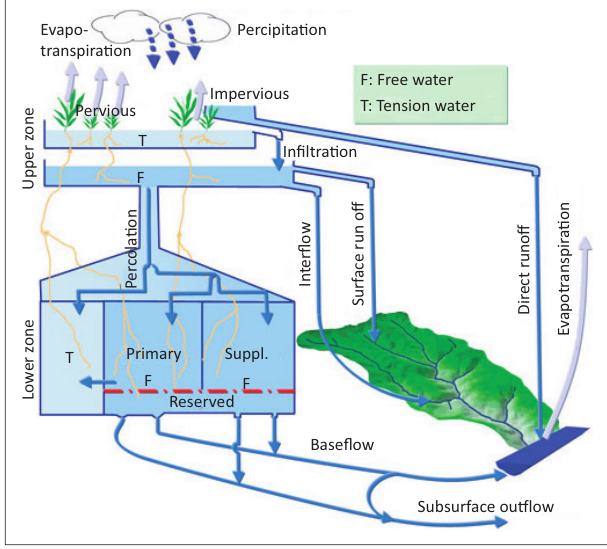
FIGURE 2: Elements of water balance in root zone